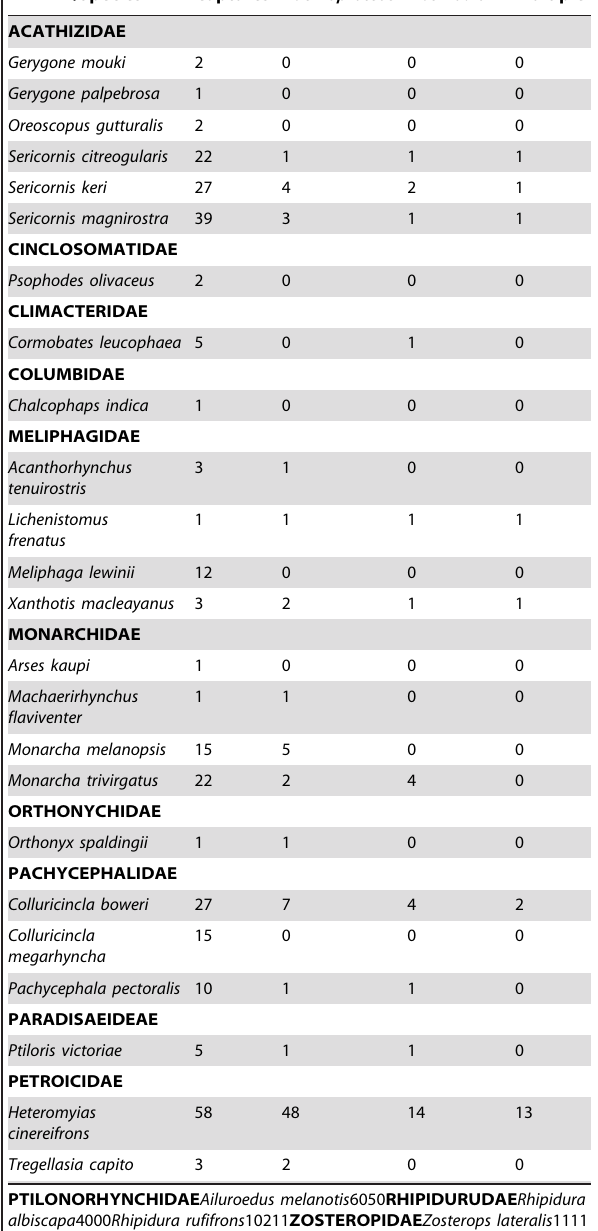
Table 1. Total captures and blood-parasite infections of rainforest bird species in fragmented and intact habitats of the Atherton Tablelands, north-eastern Australia.